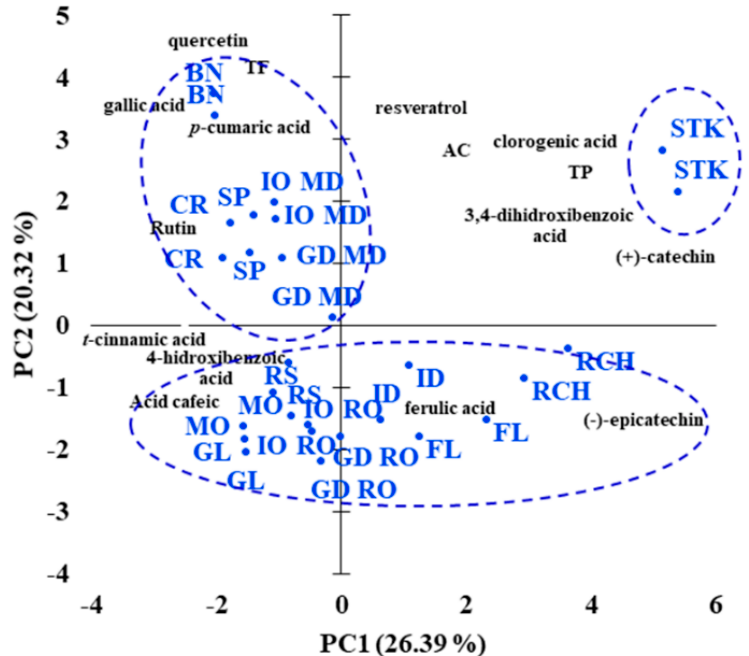
Figure 3. Bi-plot of the principal components PC1 and PC2, resulting from the PCA analysis of the polyphenolic composition of different apple cultivars.